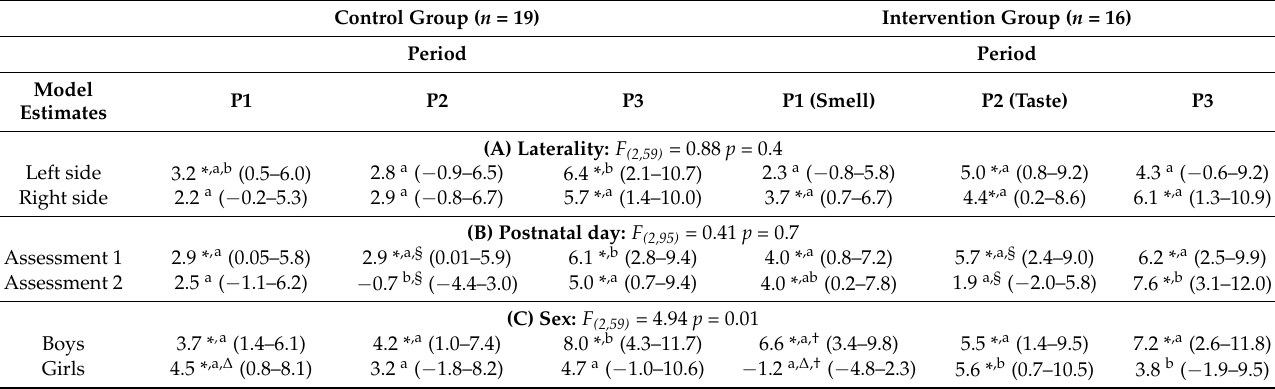
Table 2. Changes in oxygenated hemoglobin (mmol/L) concentrations from baseline. Mixed models estimates for three-way interaction between group, period, and (A) laterality; (B) postnatal day; (C)